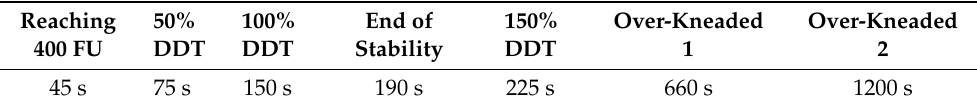
Table 1. Selected kneading times to evaluate the network evolution along the ongoing kneading process of standard wheat flour water dough.